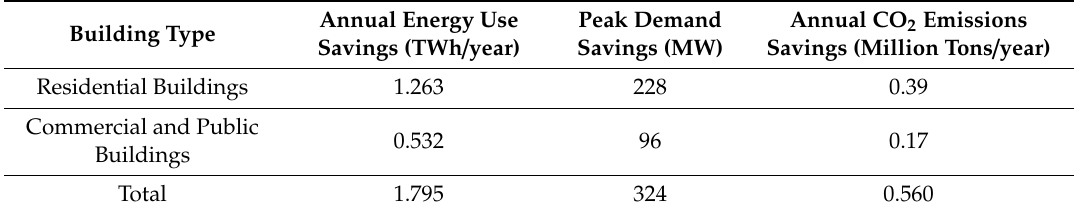
Table 19. Economic and environmental benefits for requiring better-insulated building envelope systems for all new buildings in the Arab region (only countries without any building energy e ffi ciency codes (BEECs) prior to 2014 are considered as listed in Table